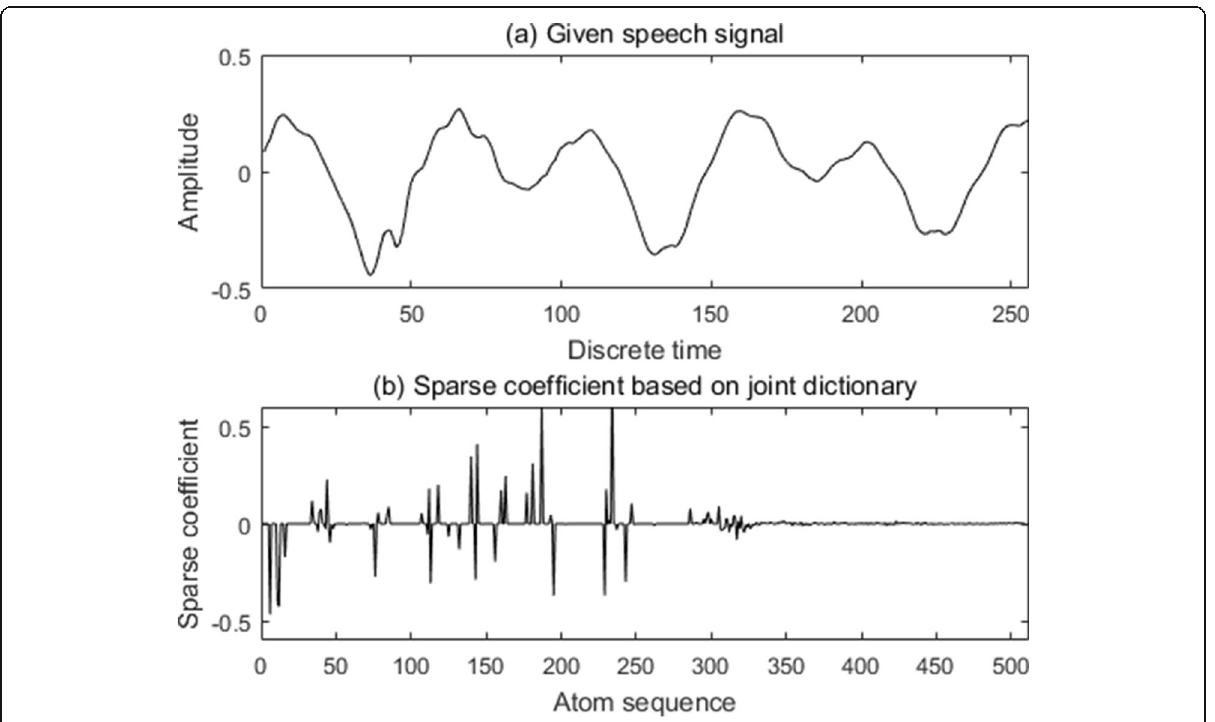
Fig. 2 Projection of a given frame signal onto the joint